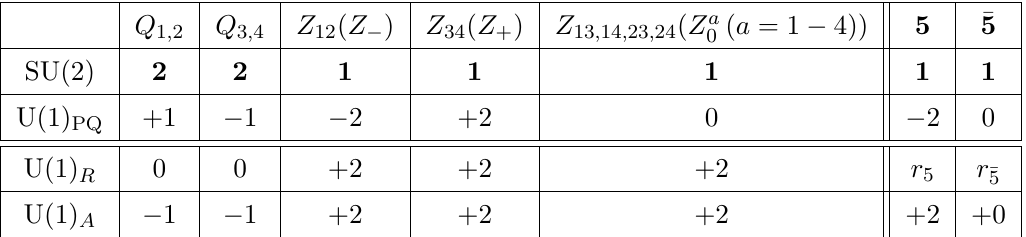
Table 1 . Charge assignment of the simultaneous symmetry breaking model. The chiral super(cid:12)elds, Q ’s, and Z ’s, are the SU(2) doublets and singlets of the IYIT model, respectively. The U(1) PQ symmetry is a subgroup of the maximum (cid:13)avor symmetry of the IYIT model. The KSVZ extra multiplets consist of the 5 and (cid:22) 5 representations of the SU(5) GUT group. The U(1) R and U(1) A symmetries are accidental symmetries of the IYIT model. A discrete subgroup of U(1) R , i.e. Z 4 R is assumed to be an exact symmetry. The R -charges of the KSVZ extra multiplets are taken to be r 5 + r (cid:22)5 =